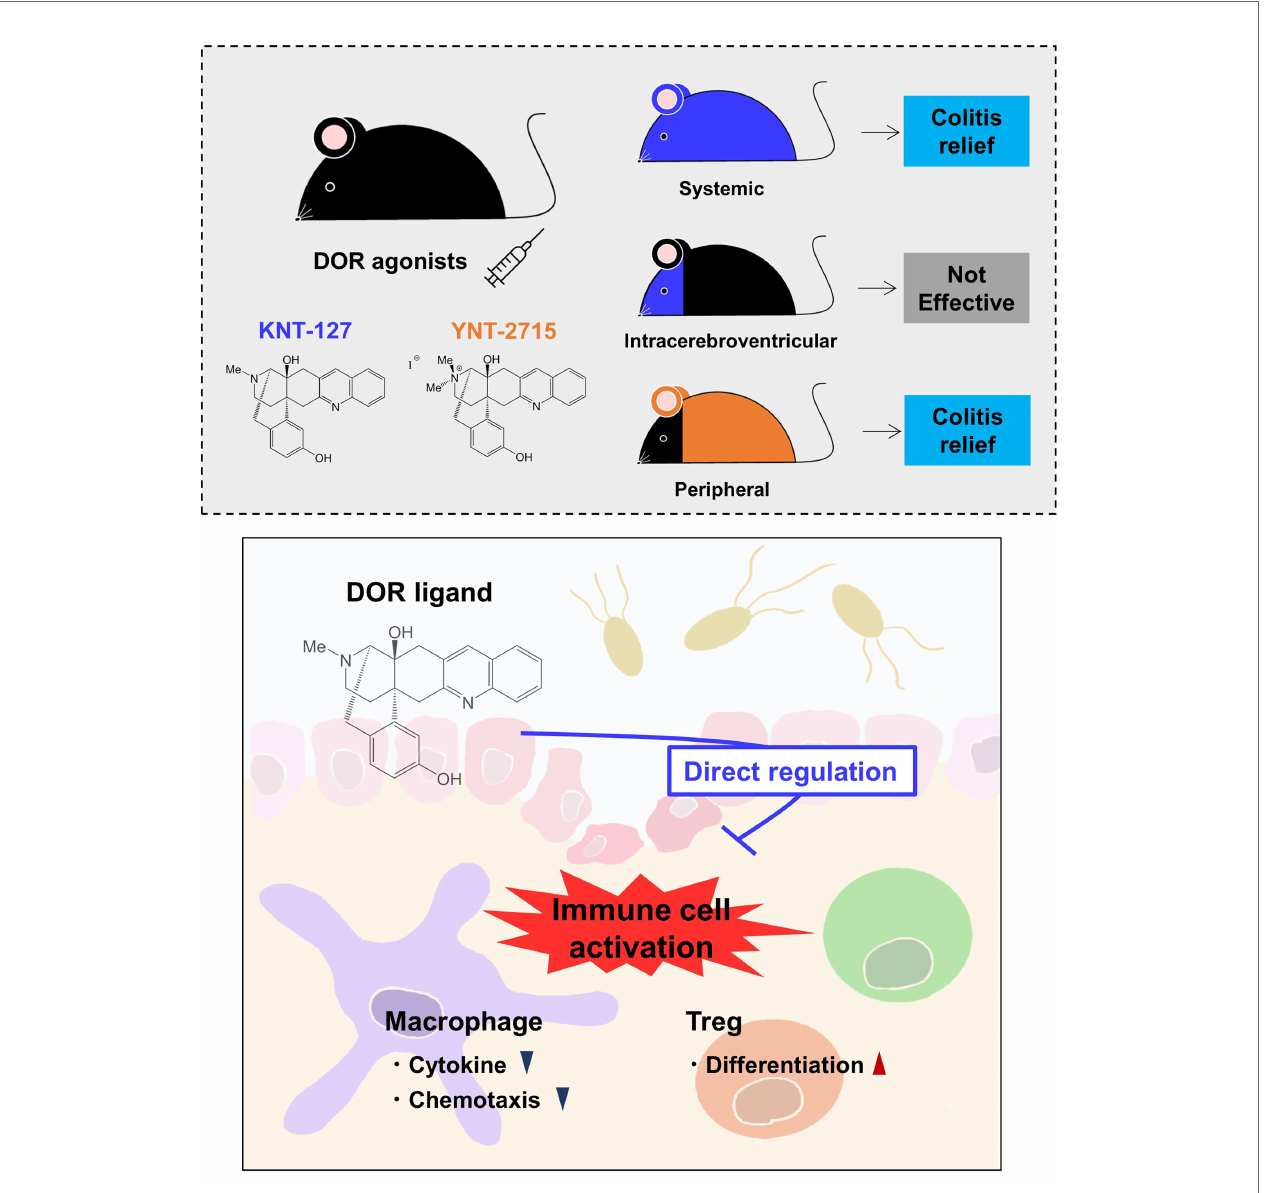
FIGURE 7 | Schematic drawing of the effects of DOR agonists on immune responses. Systemic administration of a selective DOR agonist KNT-127 and peripheral (other than the CNS) administration of a DOR agonist YNT-2715 ameliorated colitis, but intraventricular administration of KNT-127 did not cause an apparent effect on colitis (top). KNT-127 suppressed the in fl ammatory responses of macrophages, and increased Treg numbers in vivo and in vitro